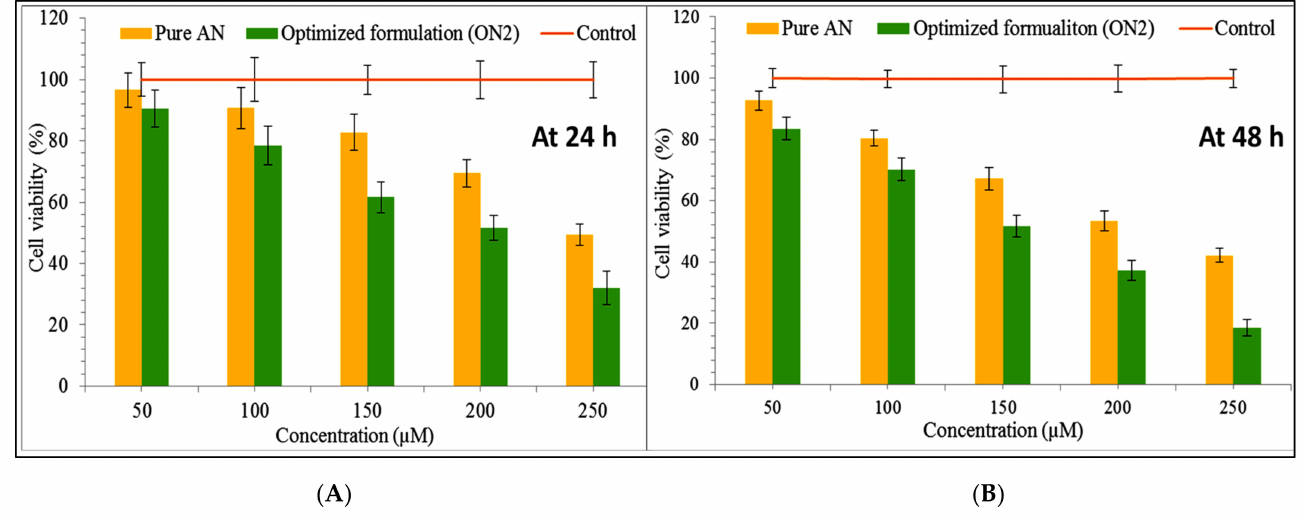
Figure 11. In vitro cell viability study graph of pure Apigenin and optimized formulation (ON2) treated with breast cancer cell line ( A ) 24 h of study; ( B ) 48 h of study. The study was performed in triplicate and data shown as mean ±